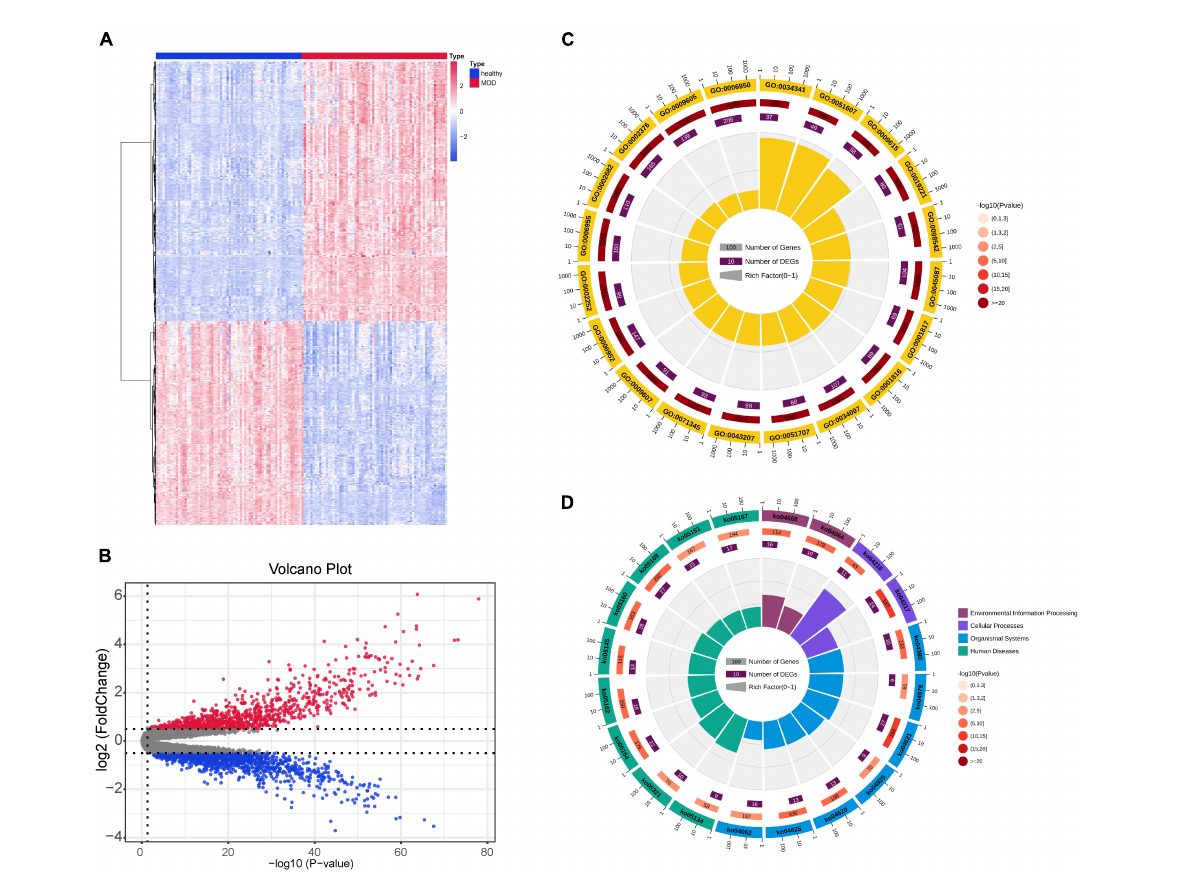
FIGURE2 DEG identification of the GSE19738 dataset. (A) DEGs of peripheral blood samples from patients with MDD and healthy controls were obtained from the DEG heat map constructed from the GSE19738 dataset. Horizontal coordinate blue represents the control group, red represents the experimental group, blue indicates low expression, and red indicates high expression. (B) Volcano diagram, black indicates genes with no differential expression, blue indicates down-regulated genes, and red indicates up-regulated genes. (C) GO enrichment analysis. The outer circle represents the number of GO term, the outer circle number represents all genes in GO term, and the inner circle number represents the number of enriched genes. The inner circle pie chart represents the percentage of genes that are enriched. (D) KEGG pathways. The outer circle represents the KEGG ID, the outer circle number represents all genes in the KEGG pathway, and the inner circle number represents the number of genes enriched in the pathway. The inner circle pie chart represents the percentage of genes that are enriched. DEGs, differentially expressed genes; GO, Gene Ontology; KEGG, Kyoto Encyclopedia of Genes and